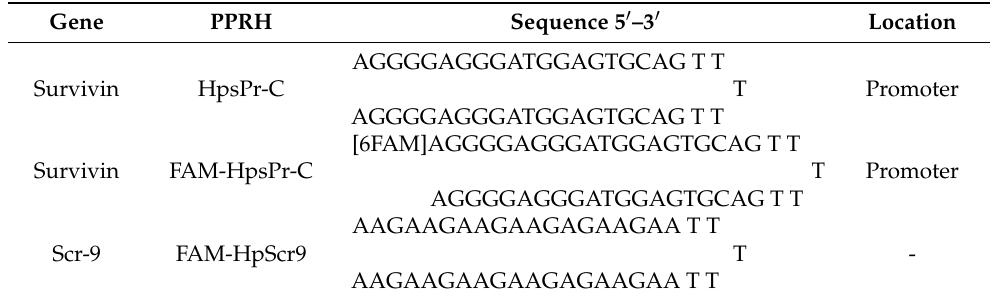
Table 1. Oligonucleotides used in this